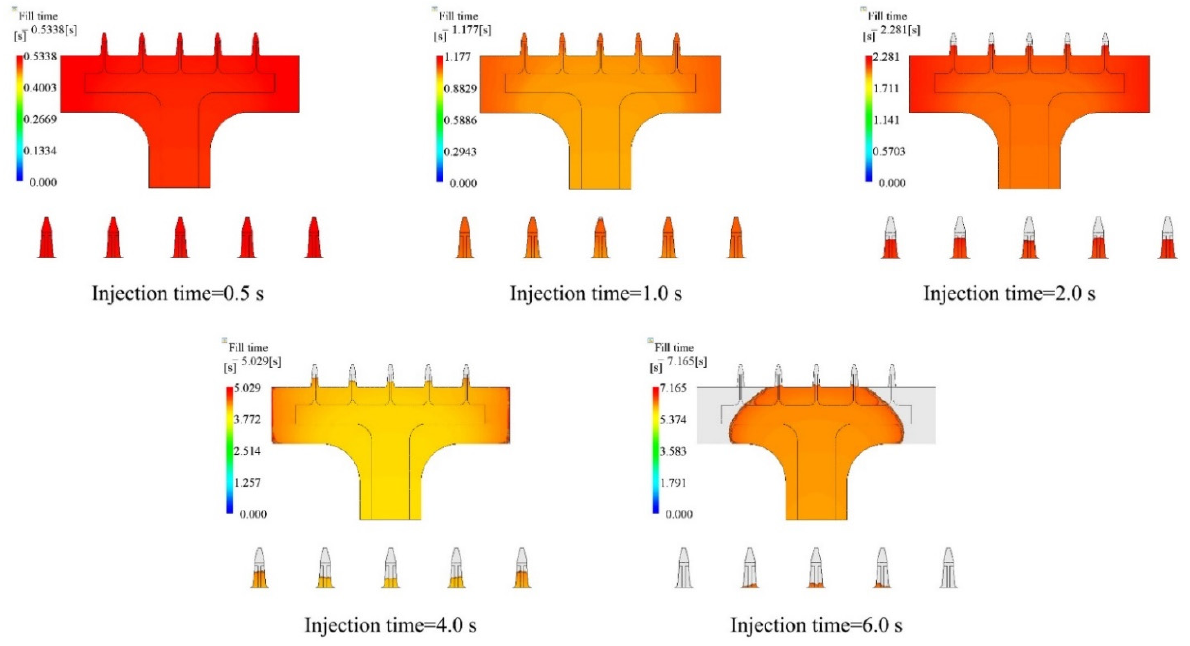
Figure 4. Filling contours for different injection time cases.